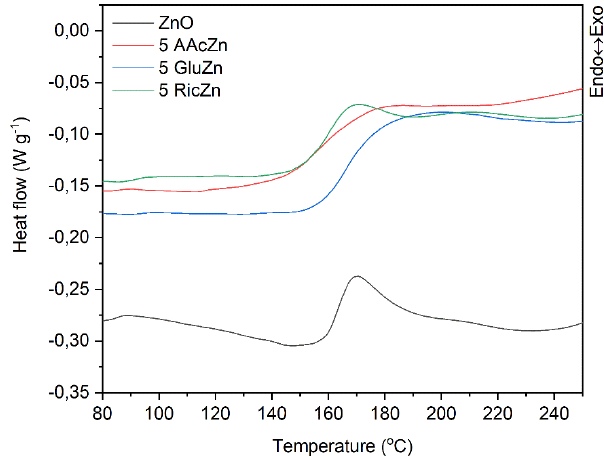
Figure 1. Differential Scanning Calorimetry (DSC) curves of SBR compounds with 3 phr of varying activators.